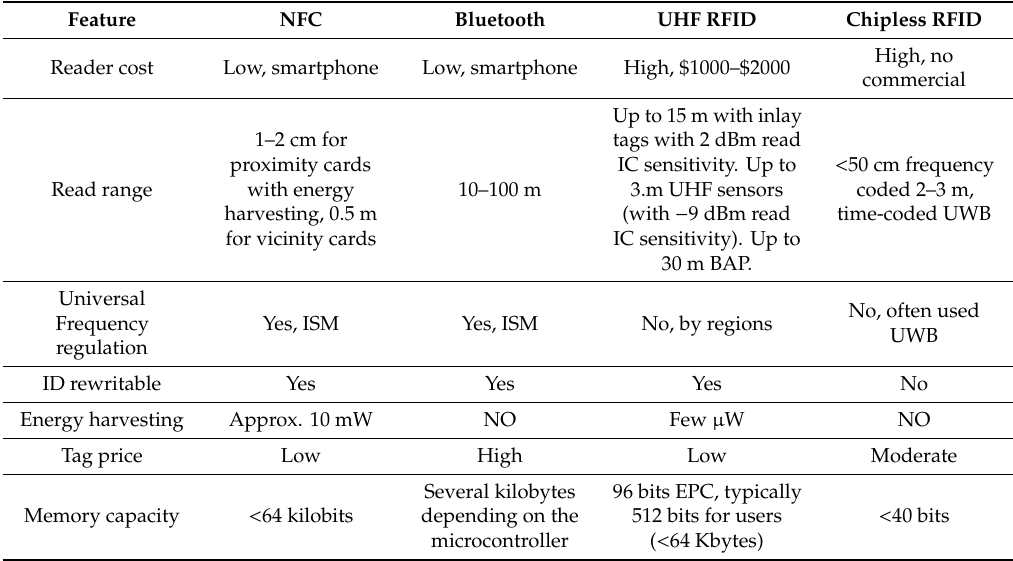
Table 1. Comparison of Several Wireless Communication Technologies.